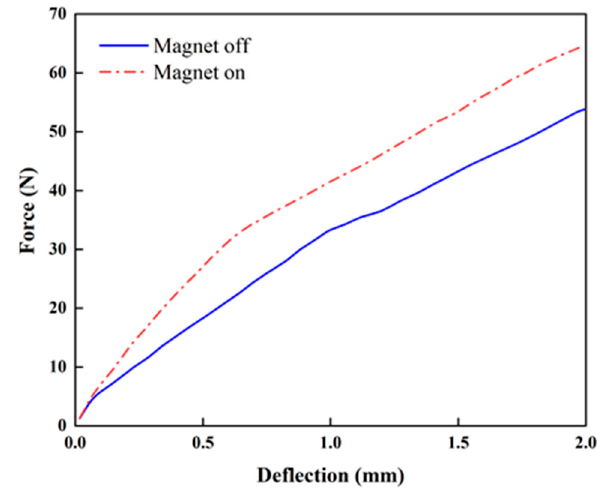
Figure 8. Sti ff ness variation of specimen 1 (lateral PM configuration, Figure 6c). Figure 8. Stiffness variation of specimen 1 (lateral PM configuration, Figure 6c).